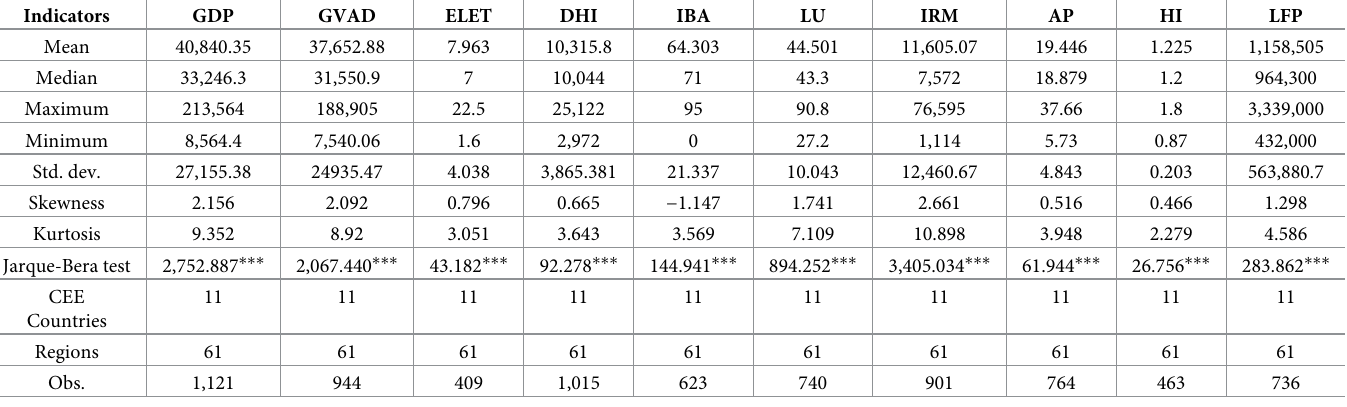
Table 4. Descriptive statistics for Central and Eastern Europe